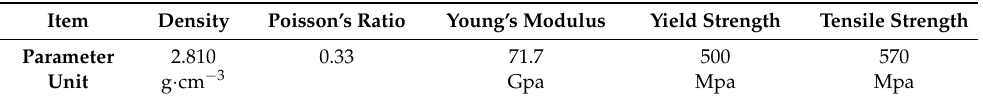
Table 2. Mechanical properties of AL